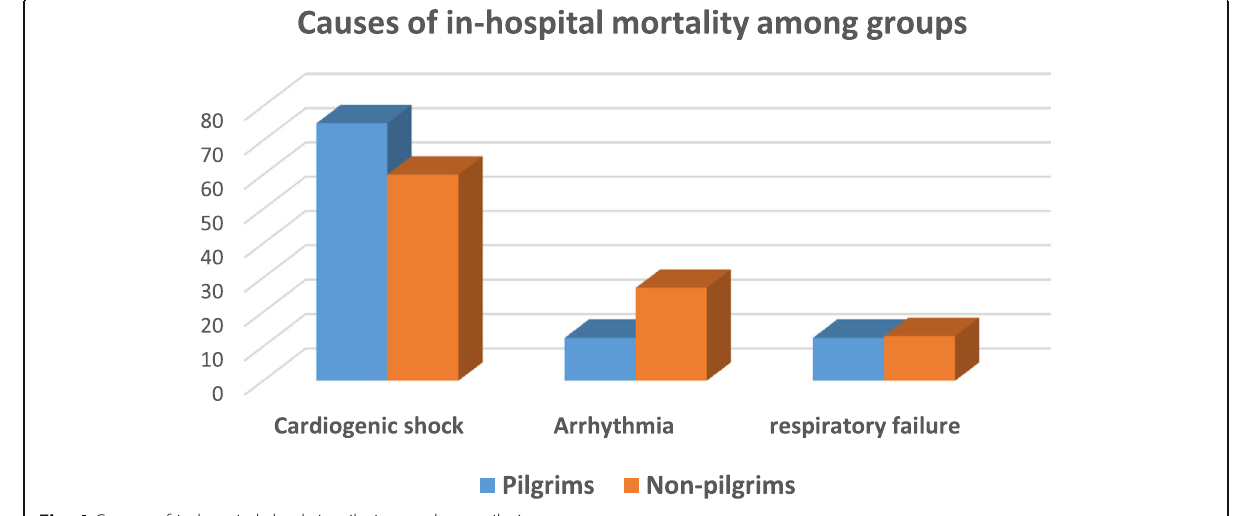
Fig. 4 Causes of in-hospital death in pilgrims and